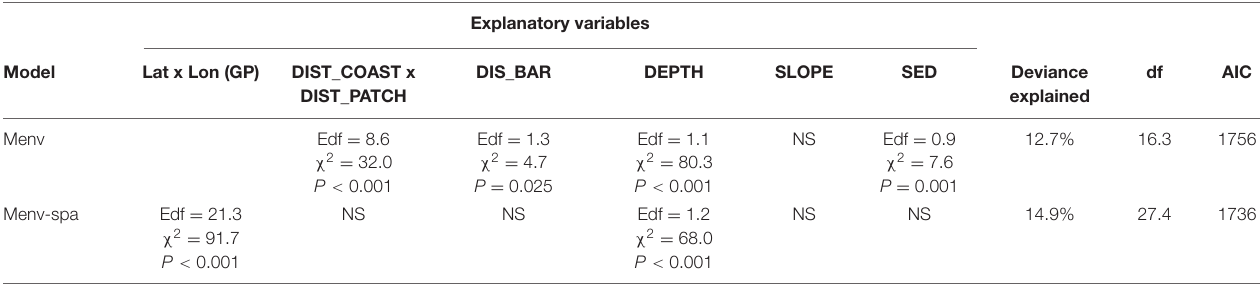
TABLE 2 | Summary of the two generalized additive models selected to estimate dolphin habitat use: M env (best environmental model) and M env-spa (equivalent combined model with environmental and spatial